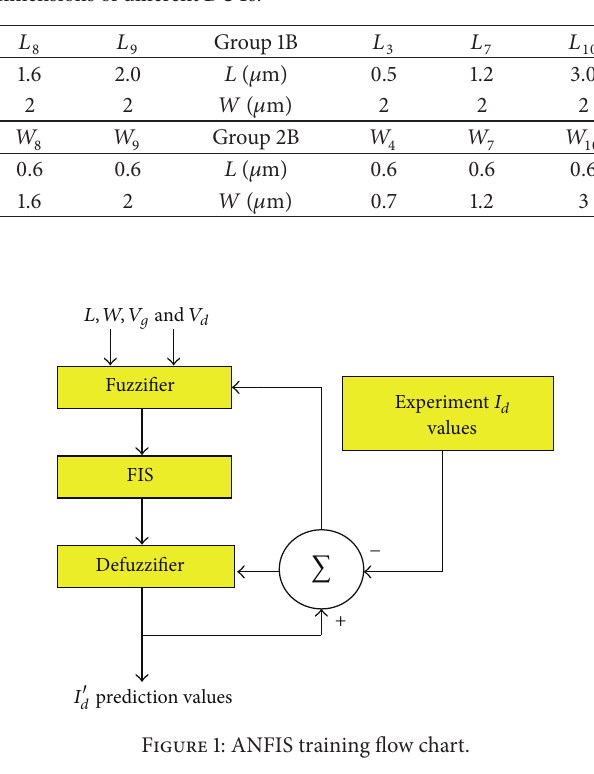
Table 1: All of device geometry dimensions of different DUTs.